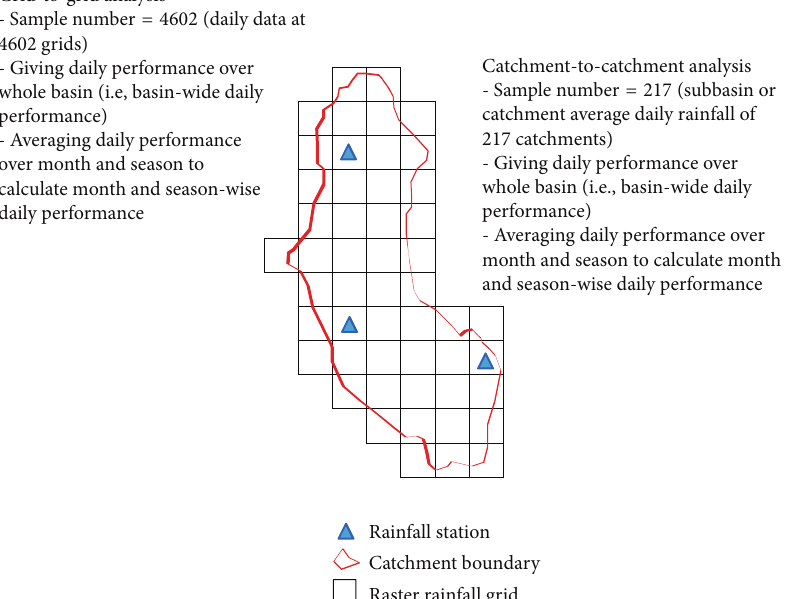
Figure 3: Illustration of data preparation method and method applied in